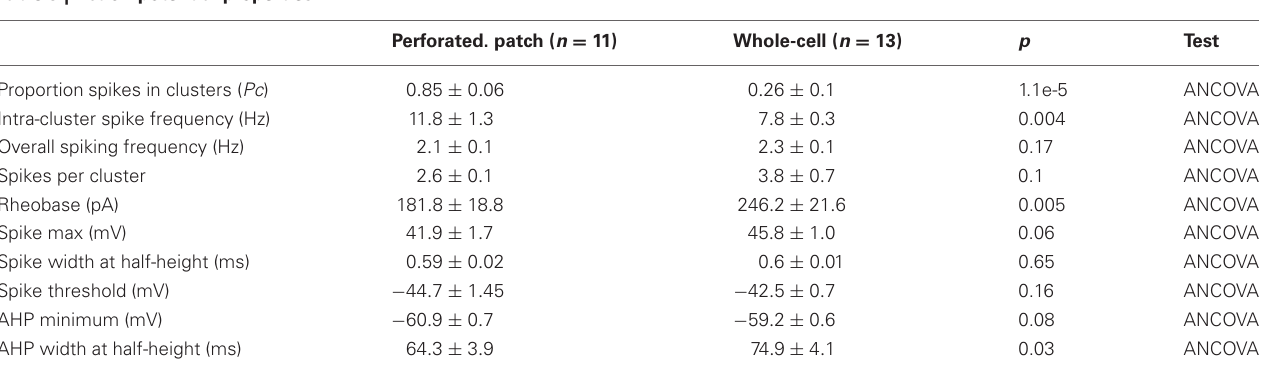
Table 3 | Action potential